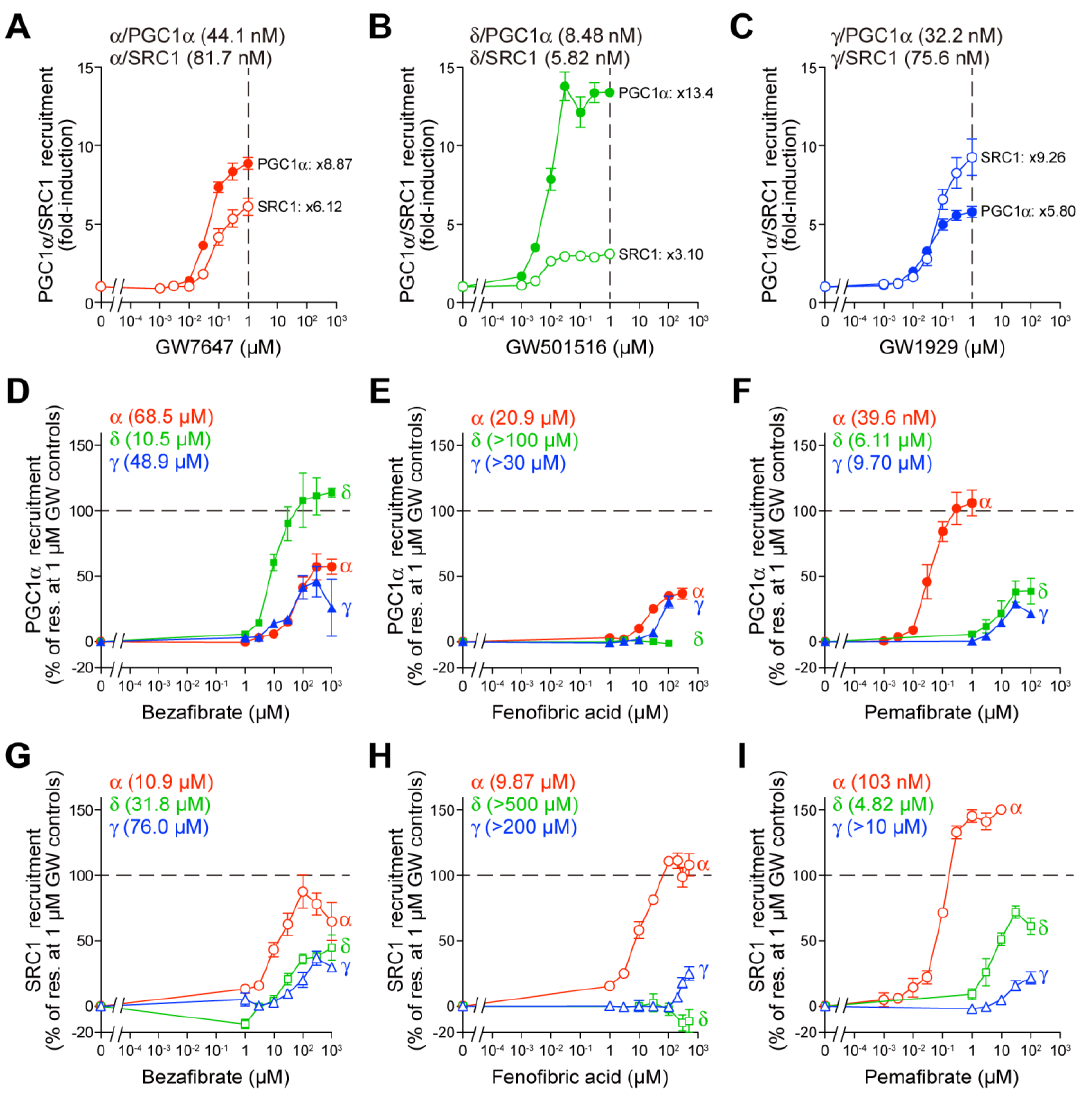
Figure 2. TR-FRET-based PPAR α / δ / γ -LBD coactivator recruitment assay. ( A – C ) Control experiments. Human PPAR α / δ / γ -LBD-mediated recruitment of coactivator peptides, PGC1 α (filled symbols) and SRC1 (open symbols), was induced by selective PPAR agonists, GW7647 for PPAR α ( A ), GW501516 for PPAR δ ( B ), and GW1929 for PPAR γ ( C ) in a concentration-dependent manner. Their maximal responses at 1 µM are used as the 100% responses in ( D – I ). ( D – I ) PPAR α / δ / γ -LBD-mediated PGC1 α ( D – F ) and SRC1 ( G – I ) coactivator peptide recruitment was induced by bezafibrate ( D , G ), fenofibric acid ( E ,H), and pemafibrate ( F , I ) in a concentration-dependent manner. Data are means ± SE of 3 – 4 independent experiments with duplicate samples, and calculated EC 50 values are shown.